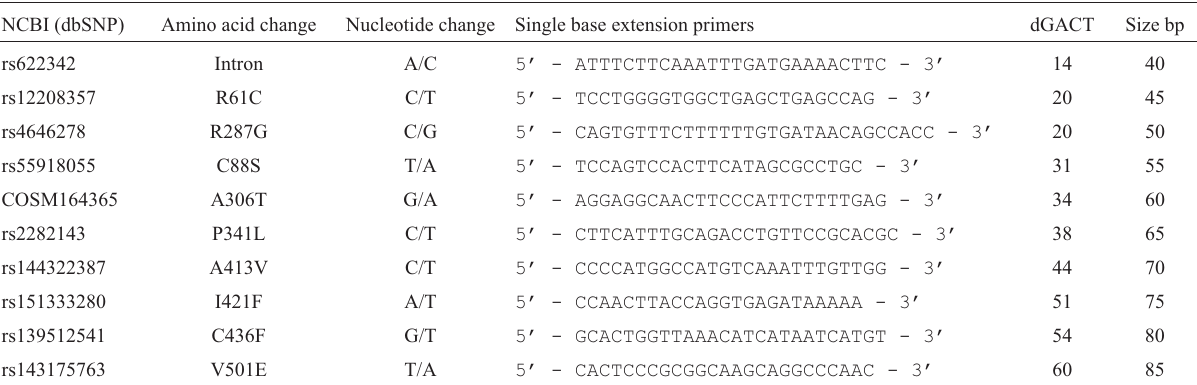
Table 3 - OCT1 multiplex 2 single base extension